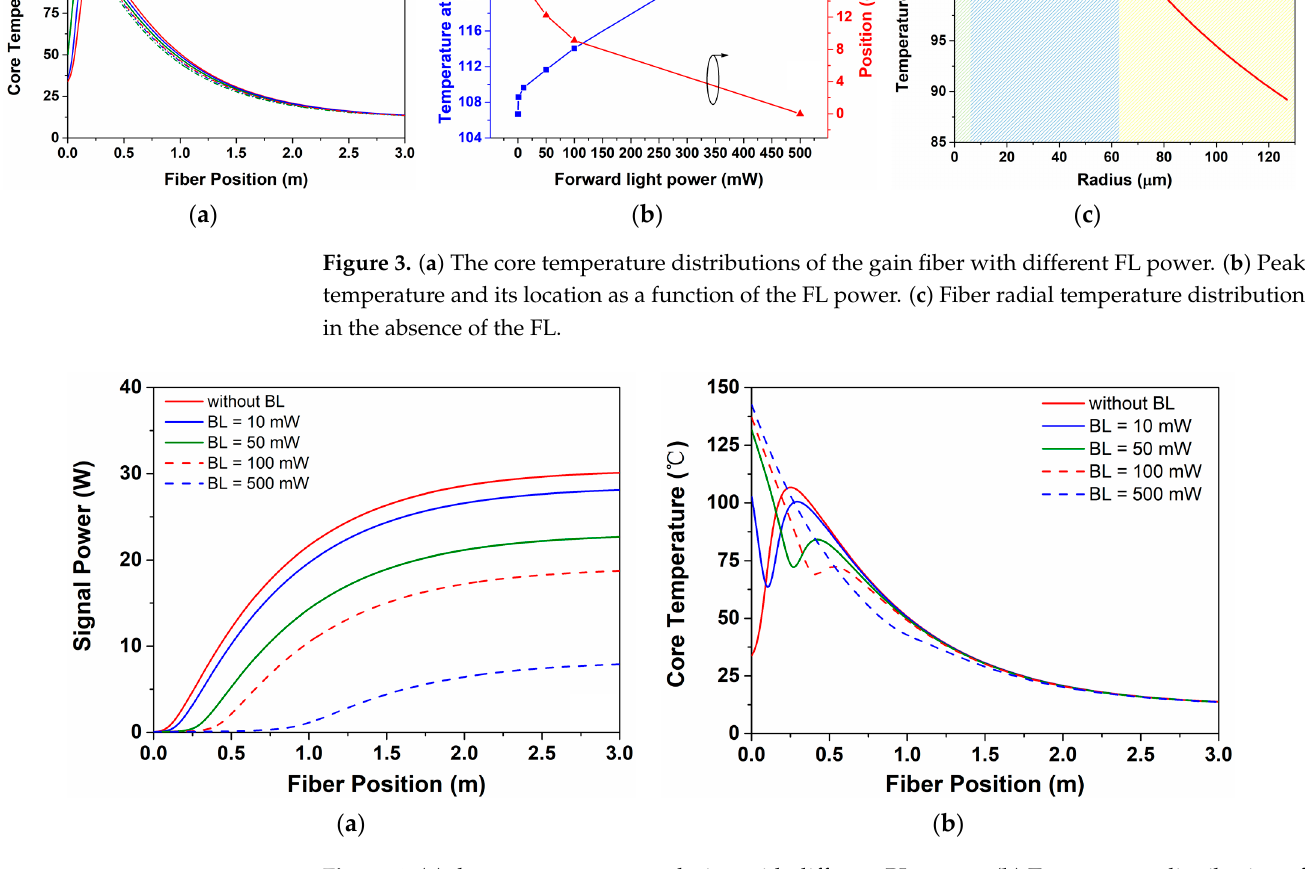
Figure 4. ( a ) the average power evolution with di ff erent BL power. ( b ) Temperature distribution of gain fi ber with di ff erent BL power. gain fiber with different BL